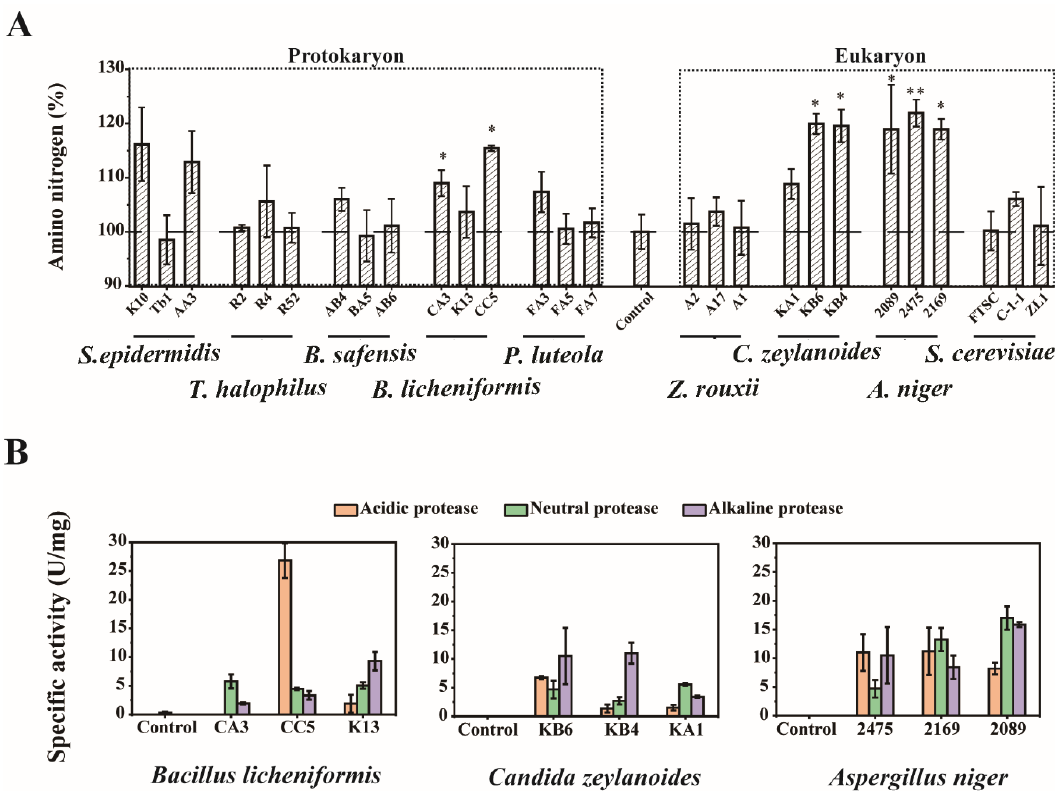
Figure 6. Batch fermentation for detecting the capabilities of polypeptide degrading microbes. ( A ) Concentrations of amino nitrogen in batch fermentation when inoculated with potential polypeptide-degrading microbes. ( B ) Specific activity of protease in acidic (pH 3.0), neutral (pH 7.0) and alkaline (pH 10.0) environments. Every species was represented by three different strains. In Figure 6A, * means p < 0.05, while ** means p < 0.01.